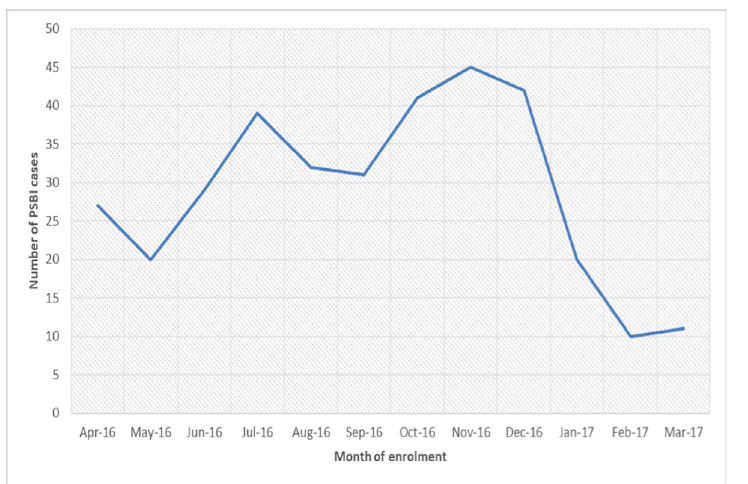
Fig 4. Identification of PSBI cases at the PHCs by